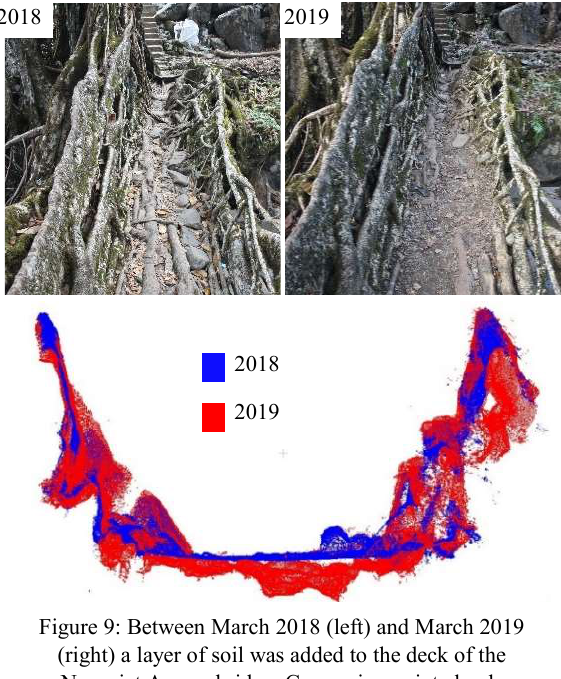
Figure 9: Between March 2018 (left) and March 2019 (right) a layer of soil was added to the deck of the Nongriat Access bridge. Comparing point clouds shows the difference in 3D (bottom).